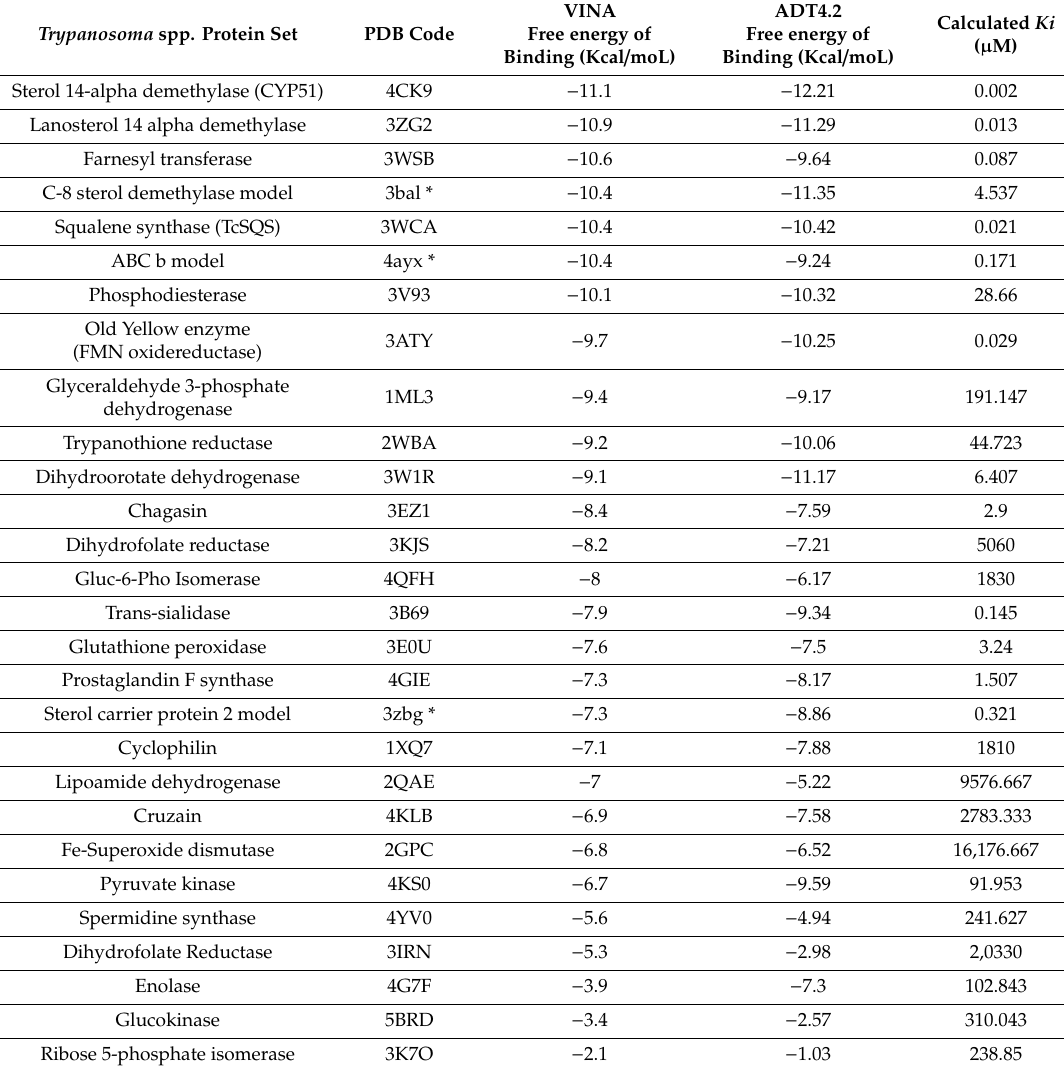
Figure 1. Molecular structure of ergosterol peroxide. ( a ) contains a side carbon 2D-chain structure, and ( b ) image contains a 3D-carbon-chain structure. The oxygen components are highlighted in red. Table 1. The best matches between T. cruzi proteins and ergosterol peroxide in descending order of ∆G predictive value.